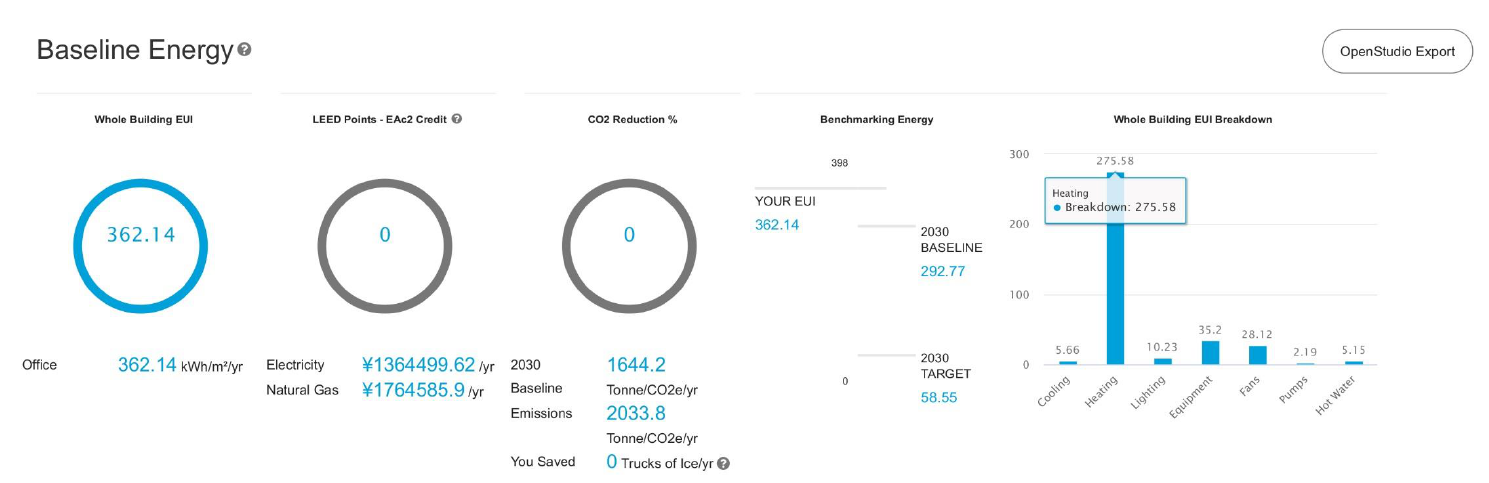
Figure A17. Zone 4-B Beijing, Beijing (post-COVID-19 78% scenario).